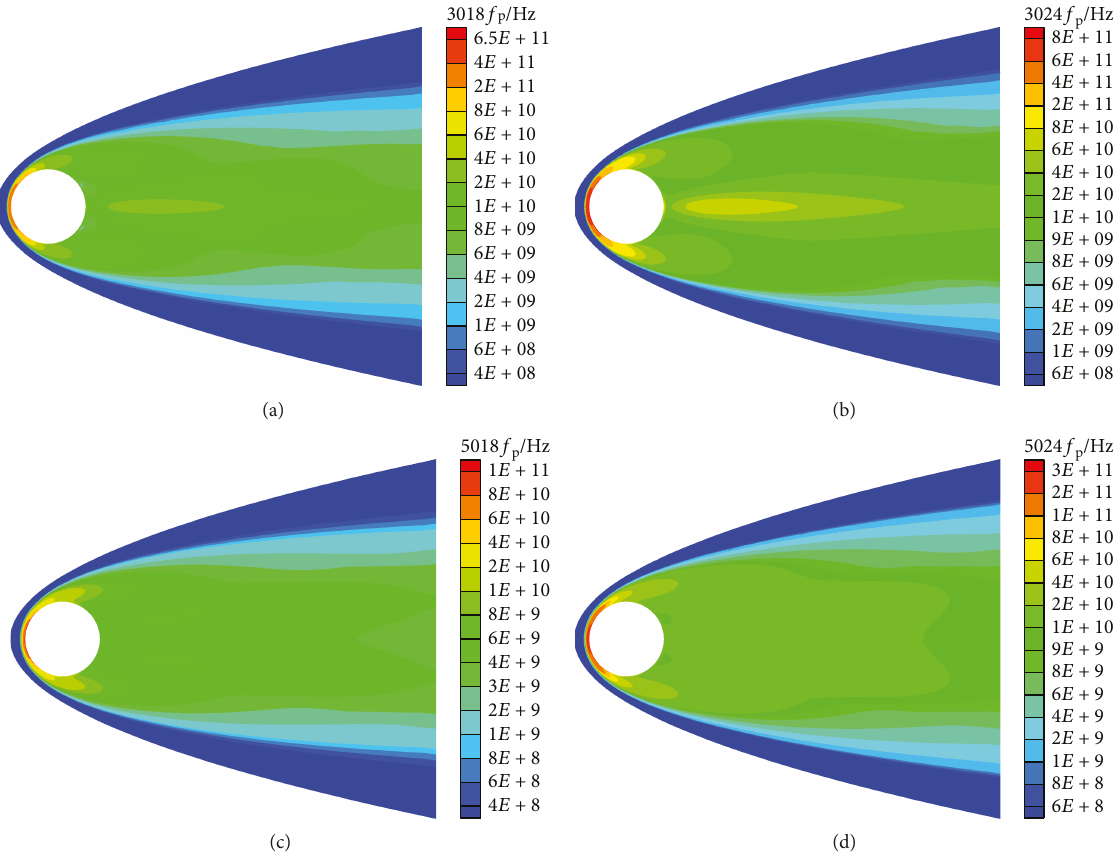
ff erent fl ight conditions for a hypersonic sphere. (a) h = 30 km, Ma = 18 ; (b) h = 30 km, Figure 5: Distributions of plasma frequency f p at di Ma = 24 ; (c) h = 50 km, Ma = 18 ; (d) h = 50 km, Ma = 24